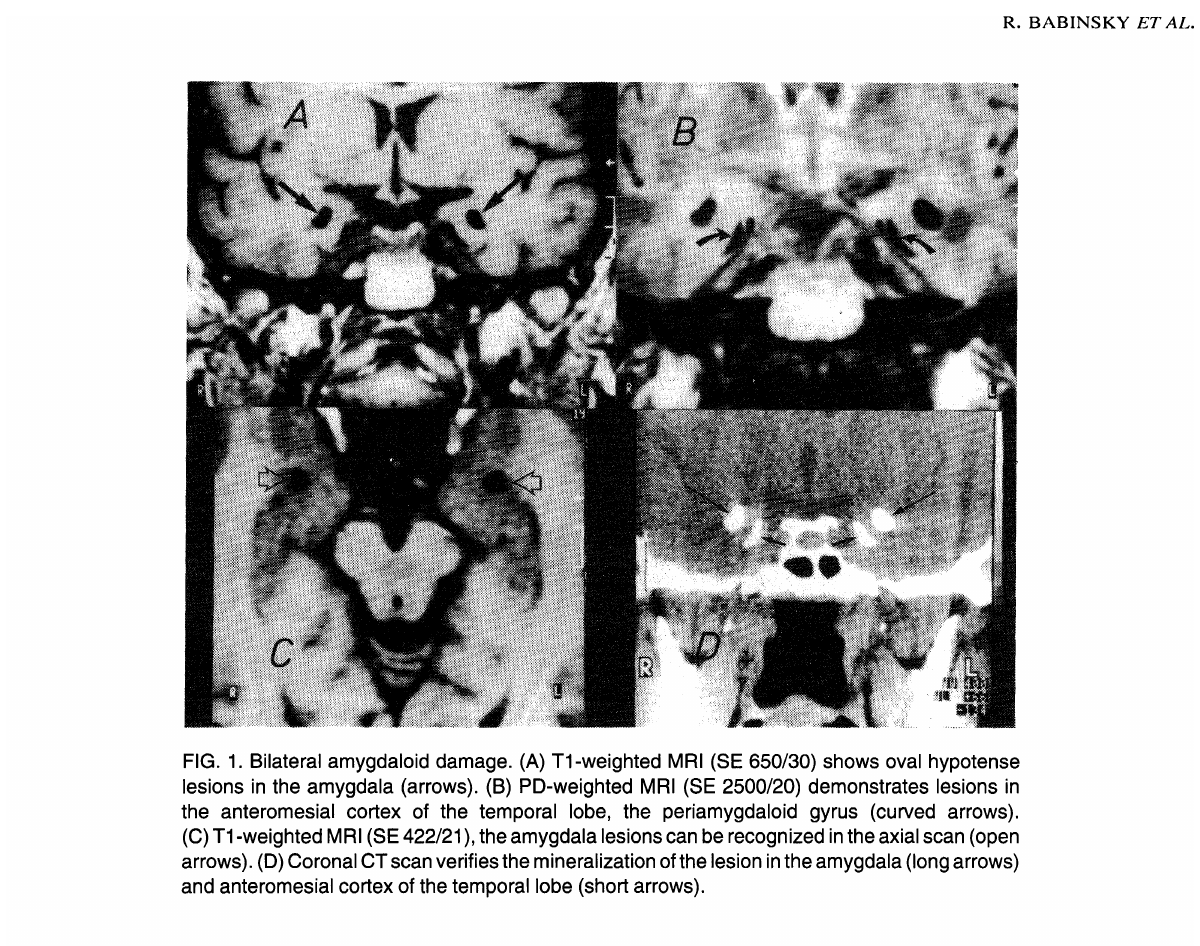
FIG. 1. Bilateral amygdaloid damage. (A) T1-weighted MRI (SE 650/30) shows oval hypotense lesions in the amygdala (arrows). (B) PD-weighted MRI (SE 2500/20) demonstrates lesions in the anteromesial cortex of the temporal lobe, the periamygdaloid gyrus (curved arrows). (C) T1-weighted MRI (SE 422/21), the amygdala lesions can be recognized in the axial scan (open arrows). (D) Coronal CTscan verifies the mineralization of the lesion in the amygdala (long arrows) and anteromesial cortex of the temporal lobe (short